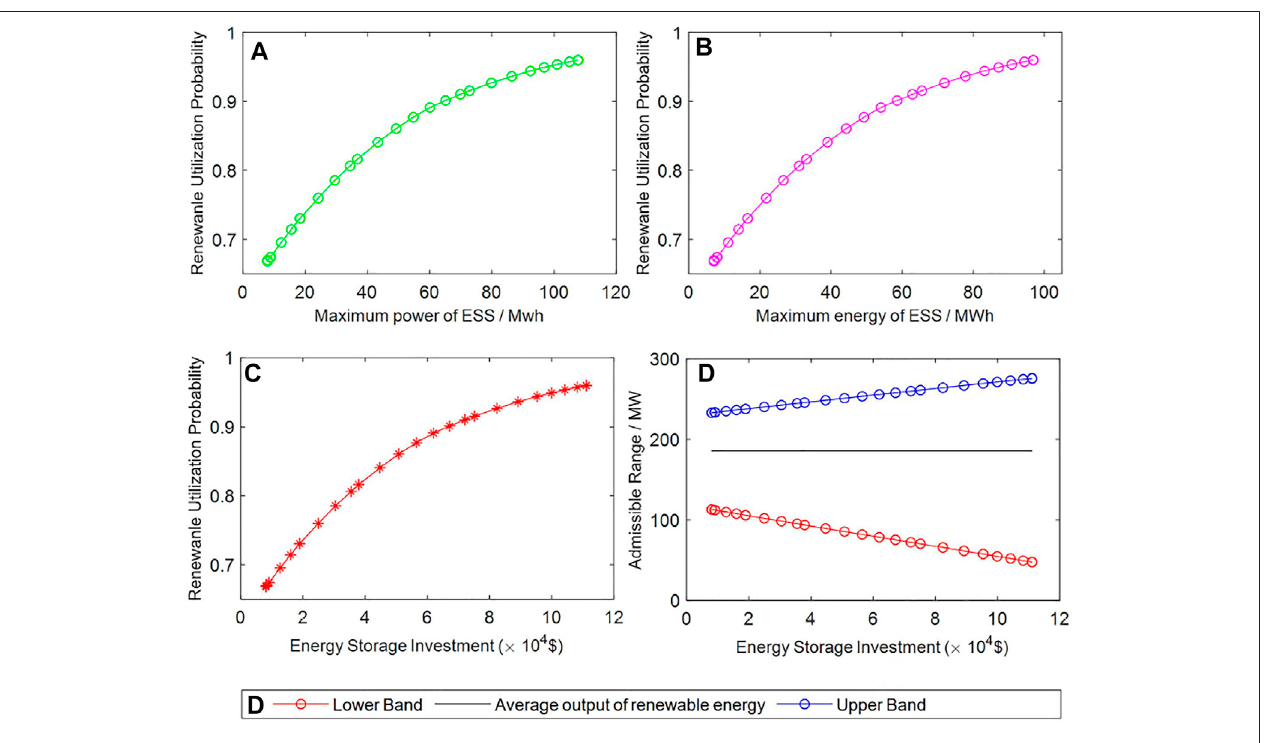
FIGURE 5 | Relationship between ESCC strategy and renewable utilization. (A) Relationship between maximum power of ESS and renewable utilization. (B) Relationship between maximum energy of ESS and renewable utilization. (C) Relationship between Energy Storage investment and renewable utilization. (D) Relationship between energy storage investment and admissible